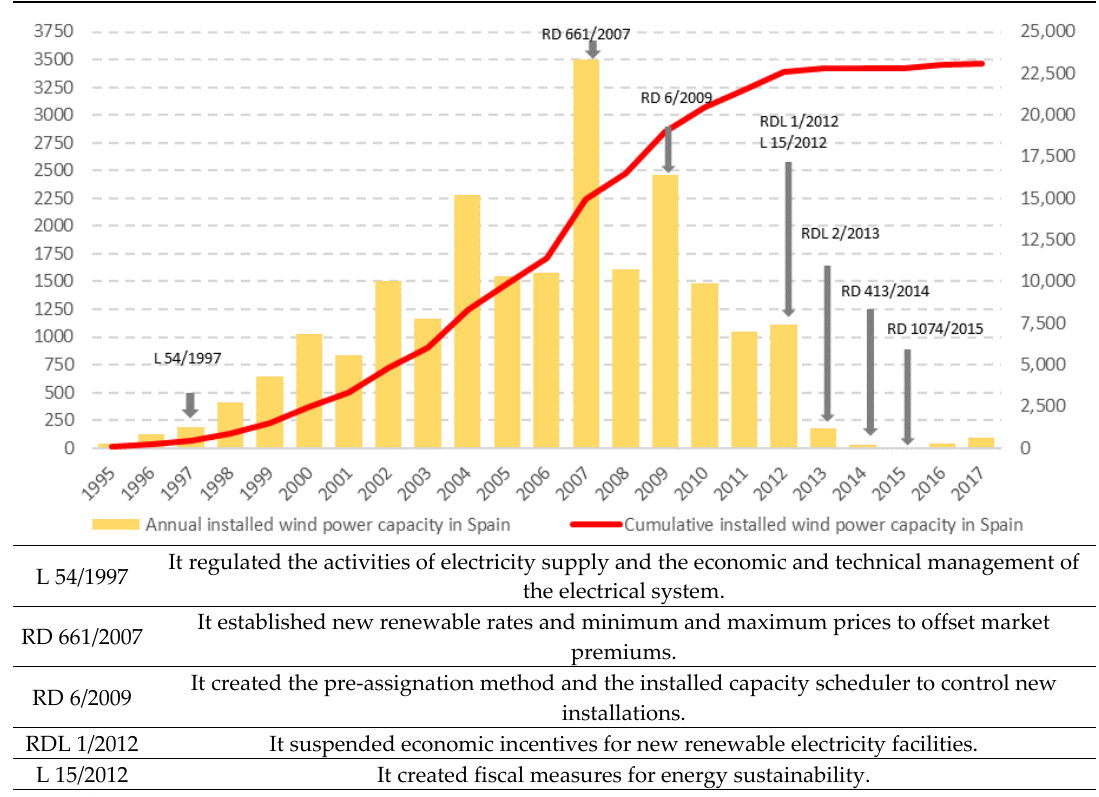
Figure 2. Installed wind power and principal legislation Spain (1995 – 2017) elaborated from [69].